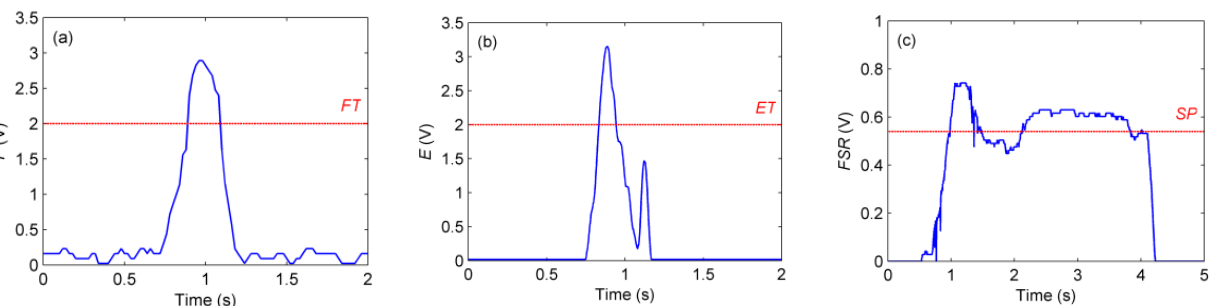
Figure 7. Examples of sensor waveforms for adjusting the threshold levels: ( a ) FMG sensor response to hand close intention; ( b ) FMG sensor response to hand open intention; ( c ) FSR response to a cylindrical grasp. The horizontal lines indicate the thresholds.